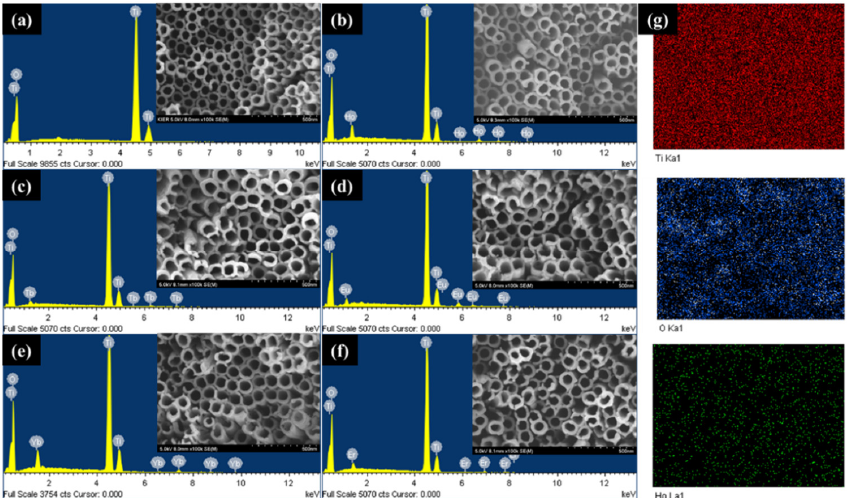
Figure 1. EDS spectra of ( a ) pure TNT, ( b ) Ho ‐ TNT, ( c ) Tb ‐ TNT, ( d ) Eu ‐ TNT, ( e ) Yb ‐ TNT, ( f ) Er ‐ TNT (insert: SEM image) and ( g ) representative scanning transmission electron microscopy elemental mapping (Ho ‐ TNT). Table 1. Elemental composition (in at. %) and structural properties of lanthanide ‐ doped TiO 2 nanotubes.